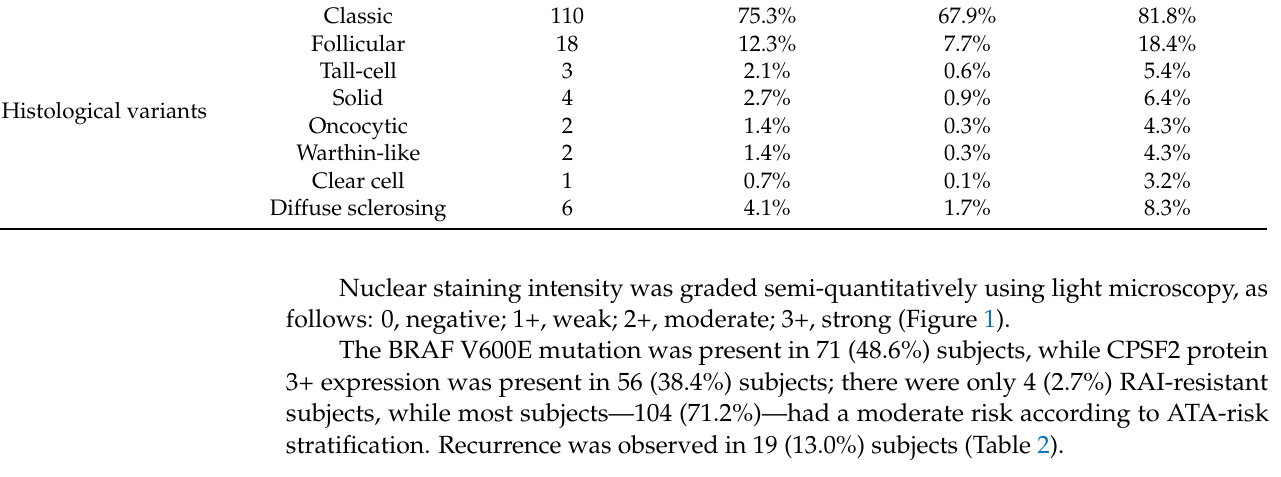
Table 2. Descriptive statistics for BRAF V600E mutation, CPSF2 expression, RAI resistance, ATA—risk stratification, and the observed recurrence among included subjects ( n =